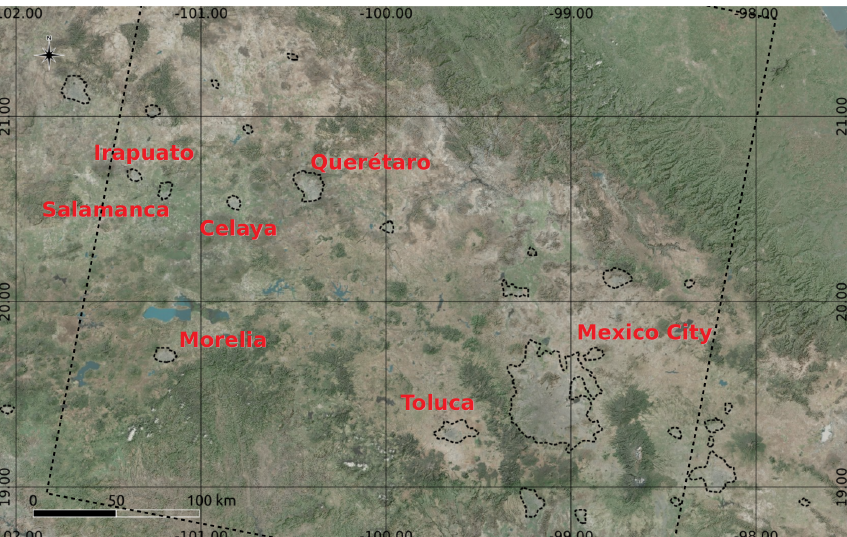
Figure 1. Bing imagery (© Microsoft) of Central Mexico overlay to a shaded relief of the SRTM digital elevation model with urban areas extents from MODIS data (Schneider et al., 2009).